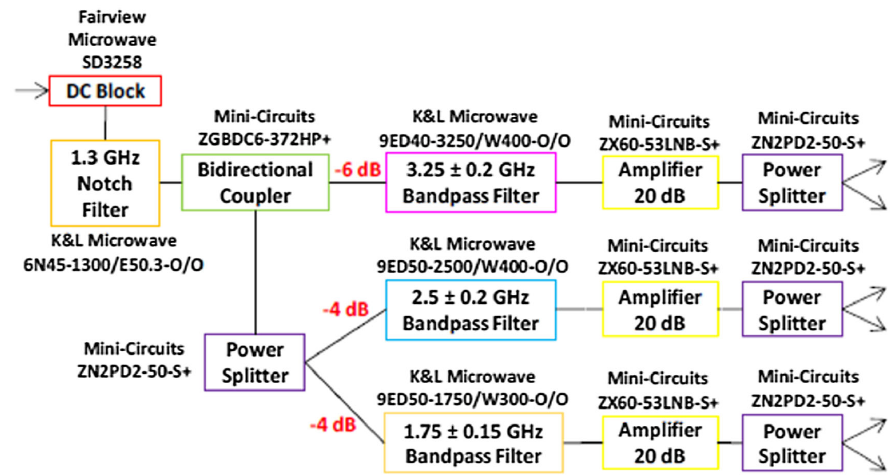
FIG. 4. Schematic of the hybrid HOM filter circuit. The red dB numbers indicate the relative amplitudes of the three channels after the combined bidirectional coupler and power splitter